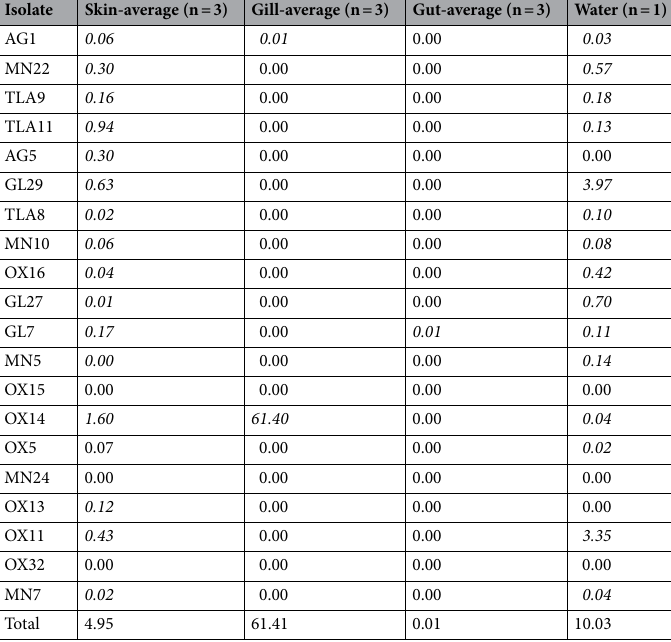
Table 2. Abundance (percentage) of each isolate in microbial communities of rainbow trout (in this study). Italics cells indicate sample with more than